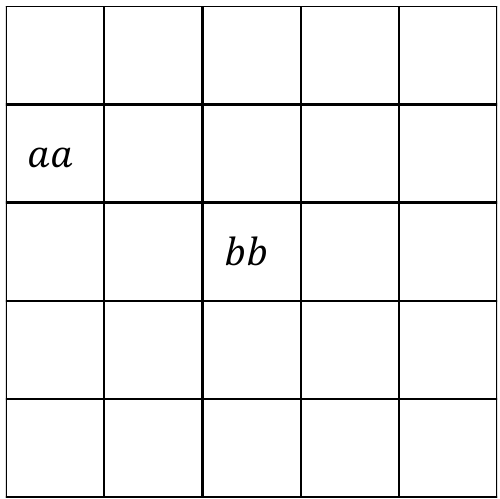
Figure 6. Example image for calculating the distance by various measures.